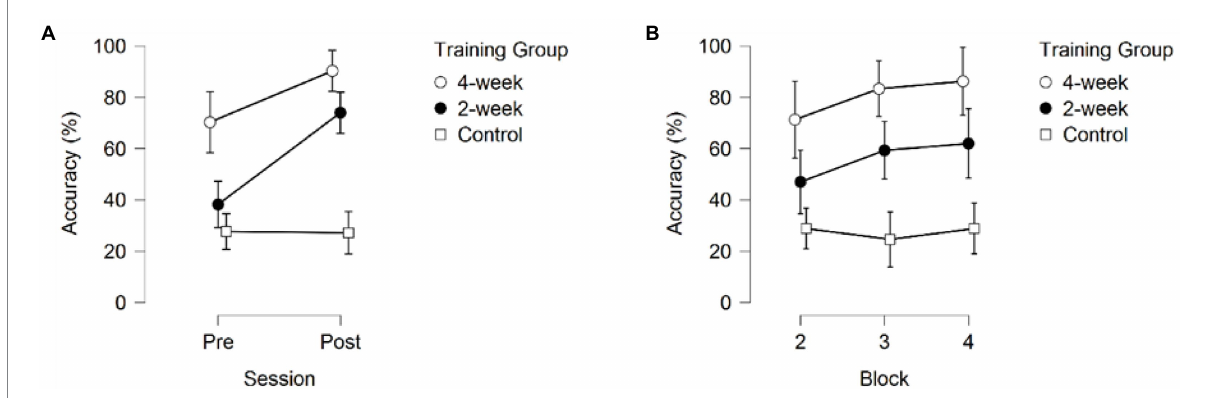
FIGURE 2 The Response Accuracy (A) across sessions, averaged over the three blocks (B) across blocks, averaged over the pre- and post-session. Error bars represent 95% CIs between groups.